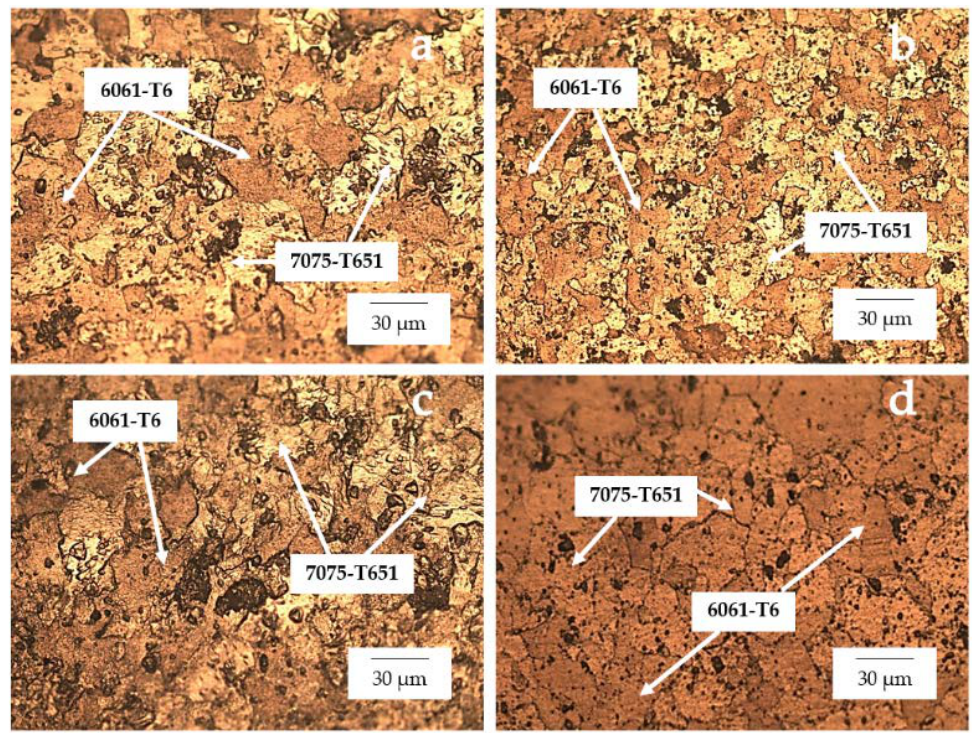
Figure 24. Microstructure of the stir zone (SZ) at 500 × ( a ) FSW; ( b ) FSW-PWHT; ( c ) FSW-DR; ( d ) FSW-PWHT-DR.